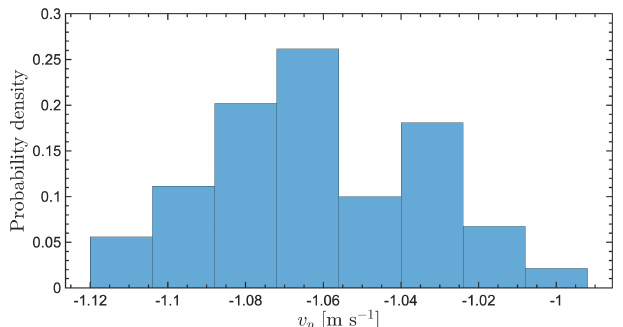
Figure A1. Simulated particle fall speed distributions for a horizon- tal wind speed of 1ms − 1 .